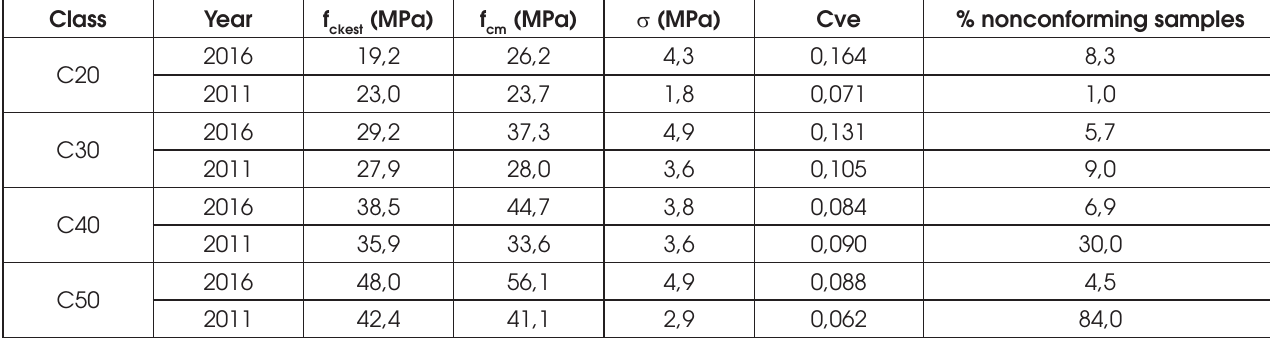
Table 5 present results obtained in terms of estimated character- istic strength (f ), mean strength (f ), standard deviation ( ), ckest cm variation coefficient (Cve) and percentage nonconforming concrete 𝝈 samples from Brazil until 2011 and 2016. The results show that, in general, there has been an increase of strength and a decrease in the percentage of nonconforming samples. For each strength class, the Figure 8 indicates the variation of the ration between the mean strength and the specified characteristic strength (f /f ), the variation of the ration between the estimates cm ck characteristic strength and the specified characteristic strength (f ck- produced until 2011 and 2016. It is possible to notice that the ra- tion between the estimated characteristic strength and the speci- fied characteristic strength (f /f ) tends to be constant only for ckest ck concrete that belonged to the current database (2016).